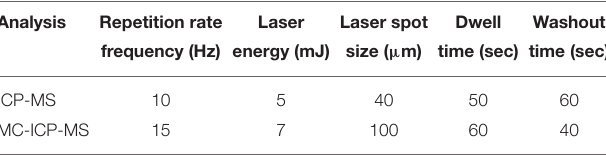
TABLE 1 | Acropora millepora juvenile coral experimental conditions and parameters. Condition